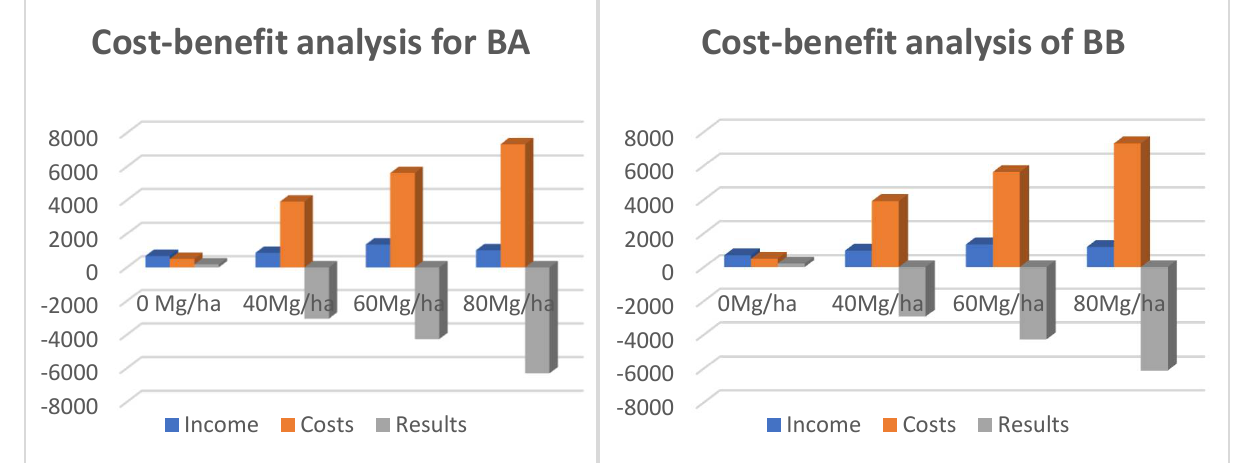
Figure 3. Comparison of the income and costs (in USD) of soybean cultivation using sunflower husk biochar (BA), left panel, and using wood chip biochar (BB), right panel.